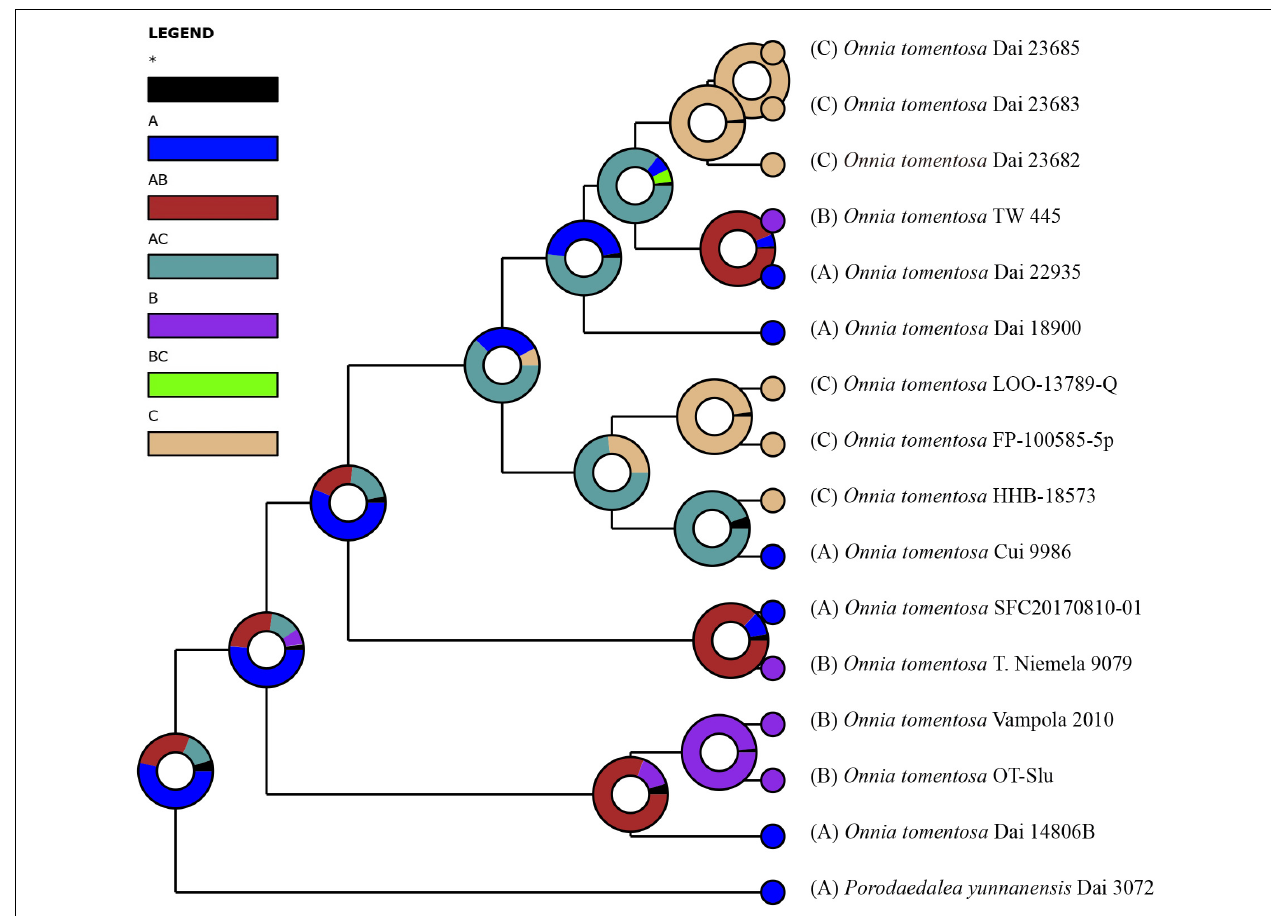
FIGURE 4 | Ancestral state reconstruction and divergence time estimation of Onnia tomentosa using a dataset containing ITS and LSU rDNA sequences. A pie chart at each node indicates the possible ancestral distributions inferred from dispersal-extinction-cladogenesis (DEC) analysis implemented in RASP. A black asterisk represents other ancestral ranges. Regions are labeled as follows: (A) Asia, (B) Europe, (C) North America, (AB) Asia and Europe, (AC) Asia and North America, and (BC) Europe and North